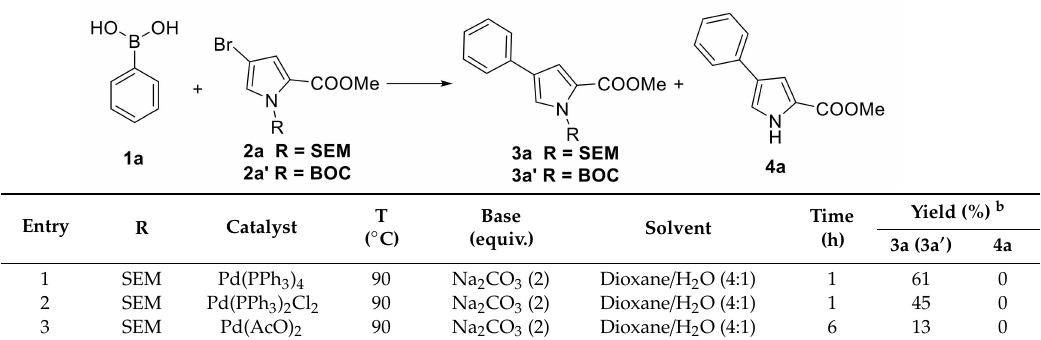
Table 1. Screening reaction conditions of Suzuki coupling a